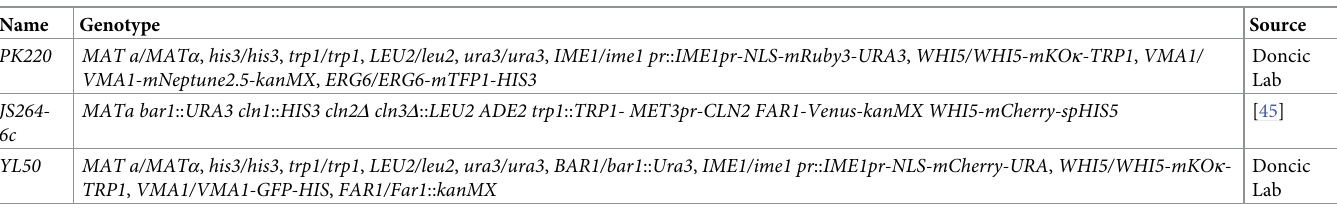
Table 9. Saccharomyces cerevisiae